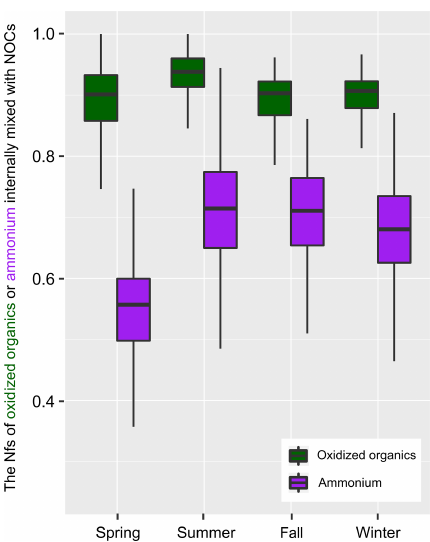
Figure 2. The variation in hourly mean Nfs of the oxidized organ- ics and ammonium (NH + ) that internally mixed with NOCs. The 4 boxes in the box and whisker plot show lower, median, and upper lines, denoting the 25th, 50th, and 75th percentiles, respectively; the whiskers denote the 10th and 90th percentiles,